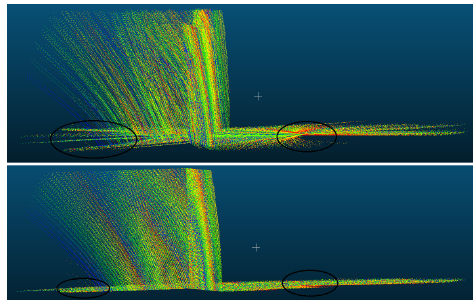
Figure 7. Simulated point cloud #1: top, before optimization of the parameters; bottom, after optimization. The two images have the same point of view.